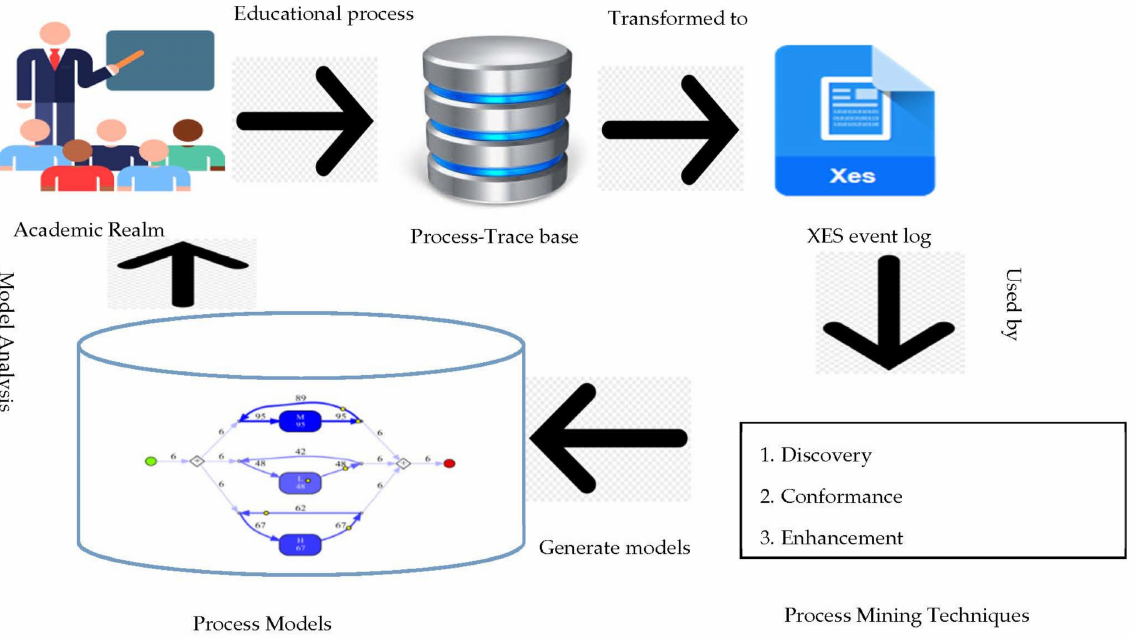
Figure 1. Education process mining